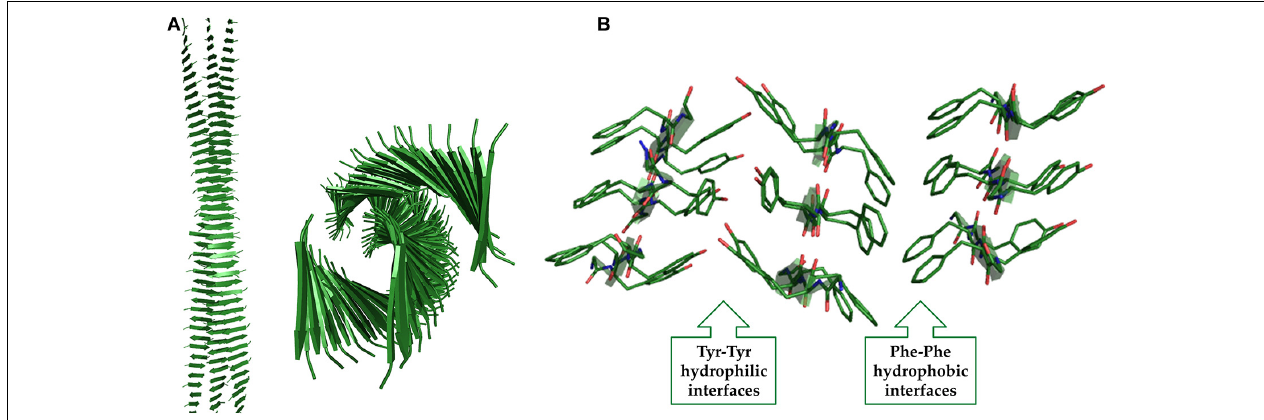
FIGURE 9 | Two different views of the (FY) 3 structure obtained from MD studies (A) . The interactions at the hydrophobic and hydrophilic interfaces are shown (B) .